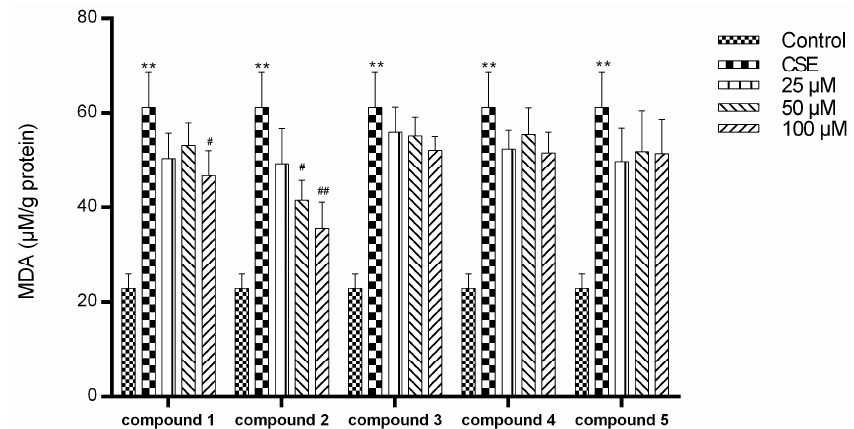
Figure 4. Effect of compounds 1 – 5 on the intracellular malondialdehyde (MDA) level in cigarette smoke (CS)-exposed A549 cells. All data were expressed as mean ± S.D., n = 6. ** p < 0.01, compared with control; # p < 0.05, ## p < 0.01, compared with the CSE group.